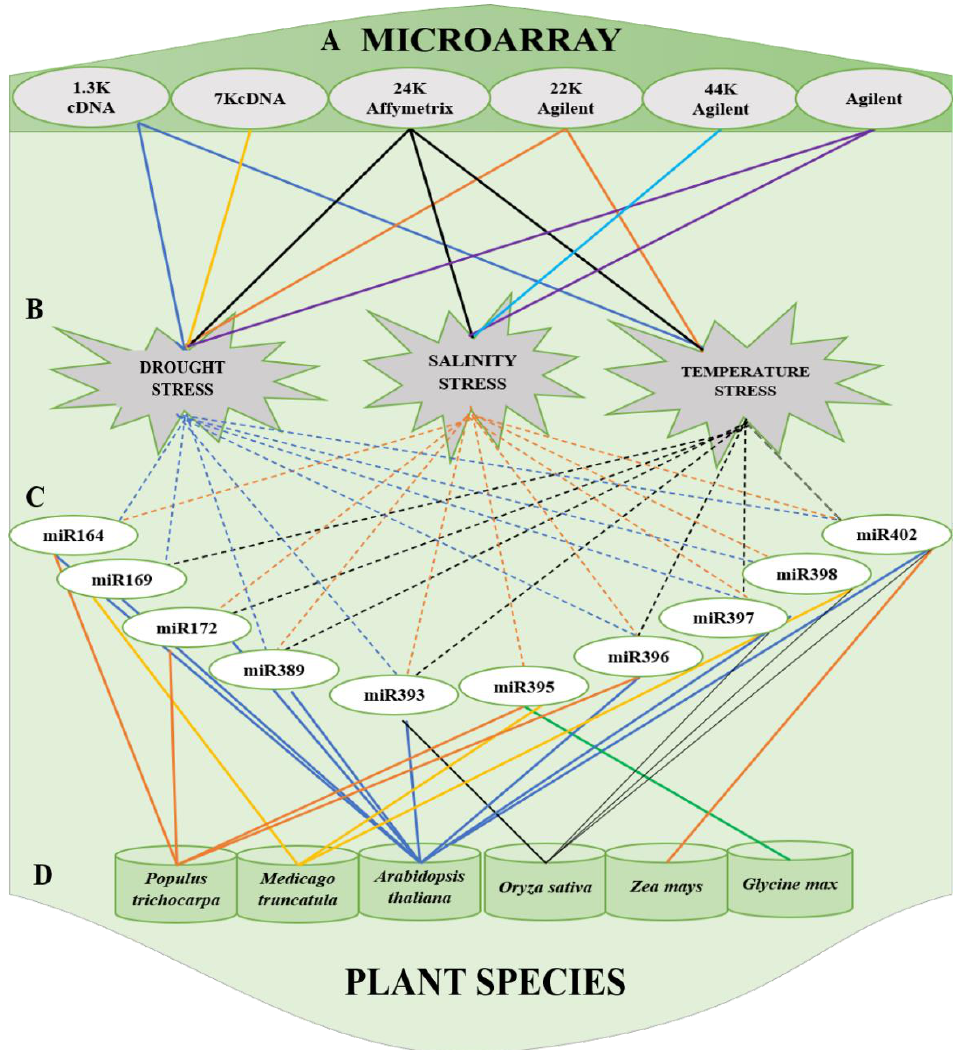
Figure 2. Summary of commonly used ( A ) microarrays (cDNA, Affymetrix, and Agilent) to stress and ( B ) miRNAs, categorized based on the stress, that respond to drought stress, salinity and temperature stress and ( C ) miRNAs reported in ( D ) plant species: Populus trichocarpa , Medicago truncatula , Arabidopsis thaliana , Oryza sativa , Zea mays and Glycine max